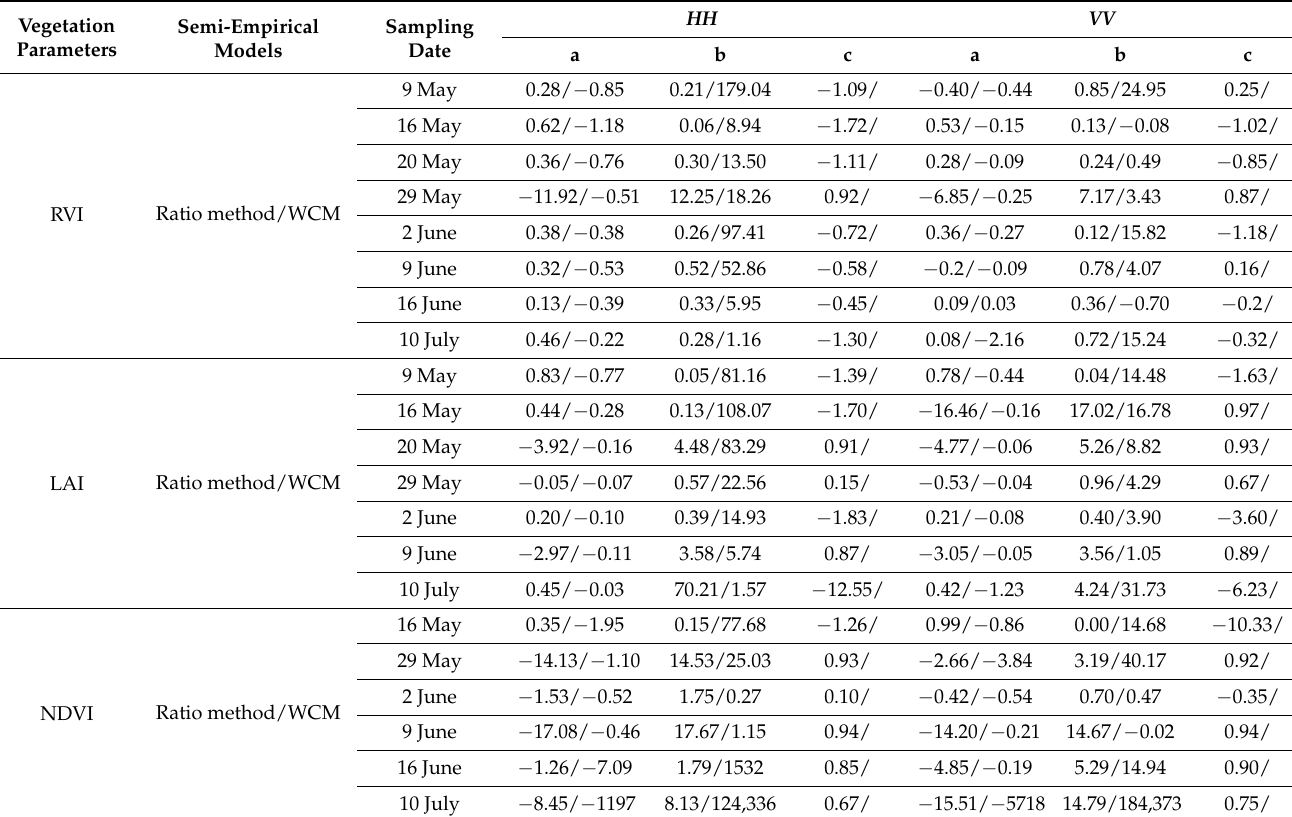
Table 2. Fitting coefficients of semi-empirical models based on RVI, LAI and NDVI.